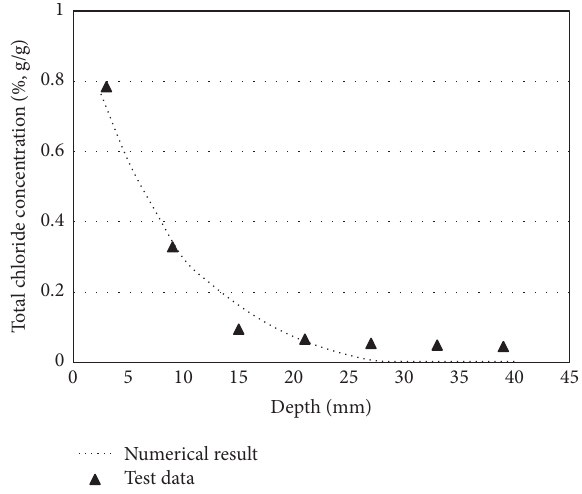
Figure 10: A comparison between numerical result and test data at 6 days of a specimen exposed to 𝑇 = 35 ∘ C.